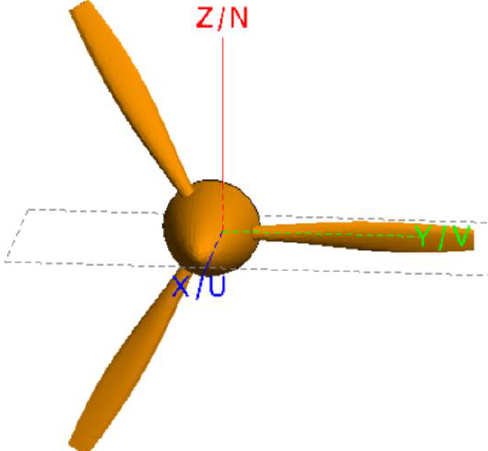
Figure 5. The flowchart of the turbine blade micro-motion simulation experiment.